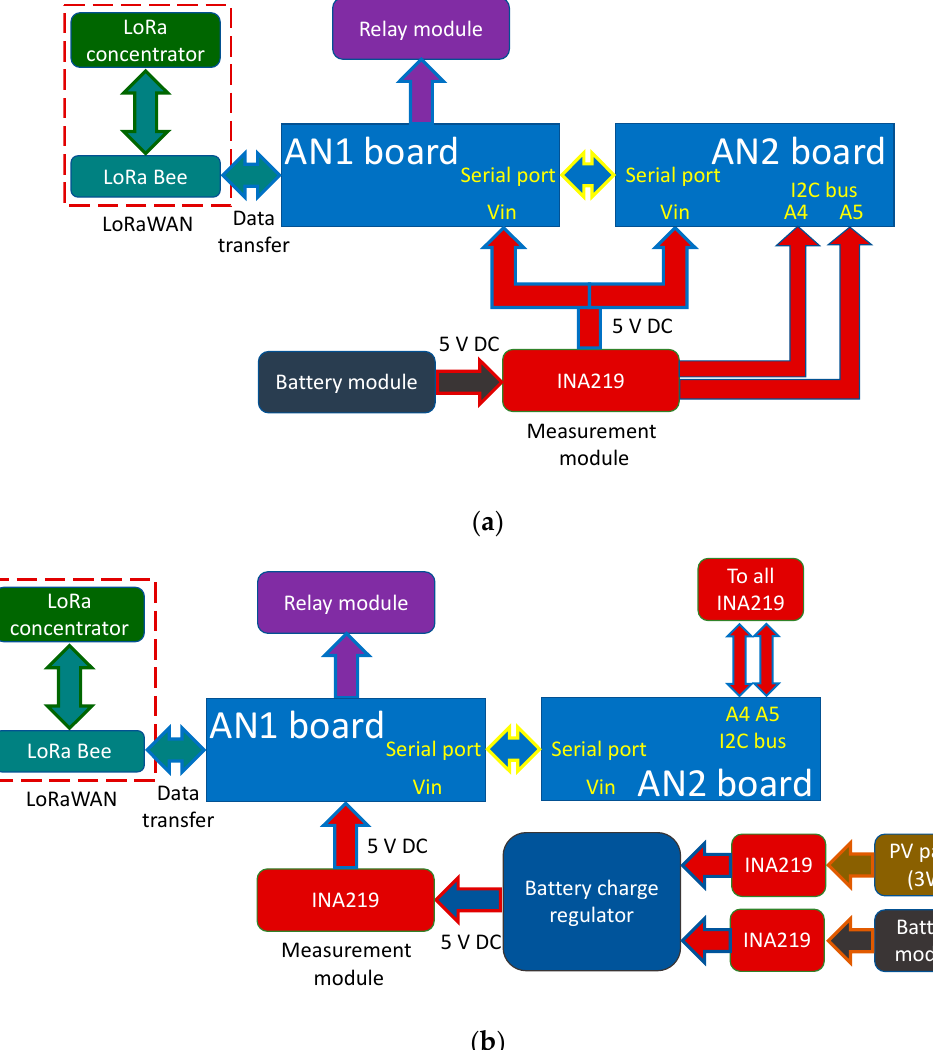
Figure 7. Block diagram of the ECDL: ( a ) battery power supply and ( b ) battery and solar panel power supply.